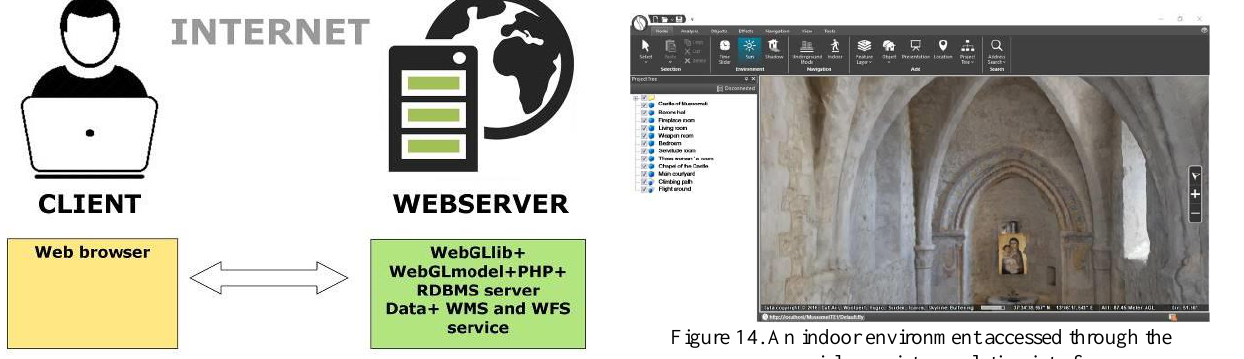
Figure 12. The connection between client-side and server-side chosen for the open-source solution 4.2. The comparison between the studied open-source